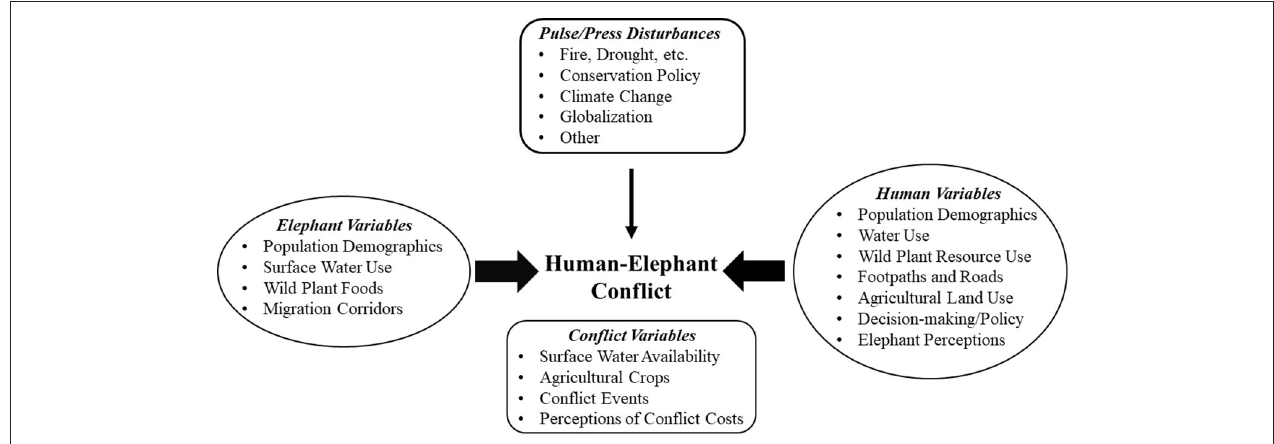
FIGURE 2 | Human and elephant population variables drawn from a multitude of coupled system components and processes. Additional information for variables is provided in the text.